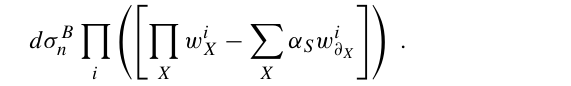
be constructed by rearranging the expressions in a way that keeps the α S expansion